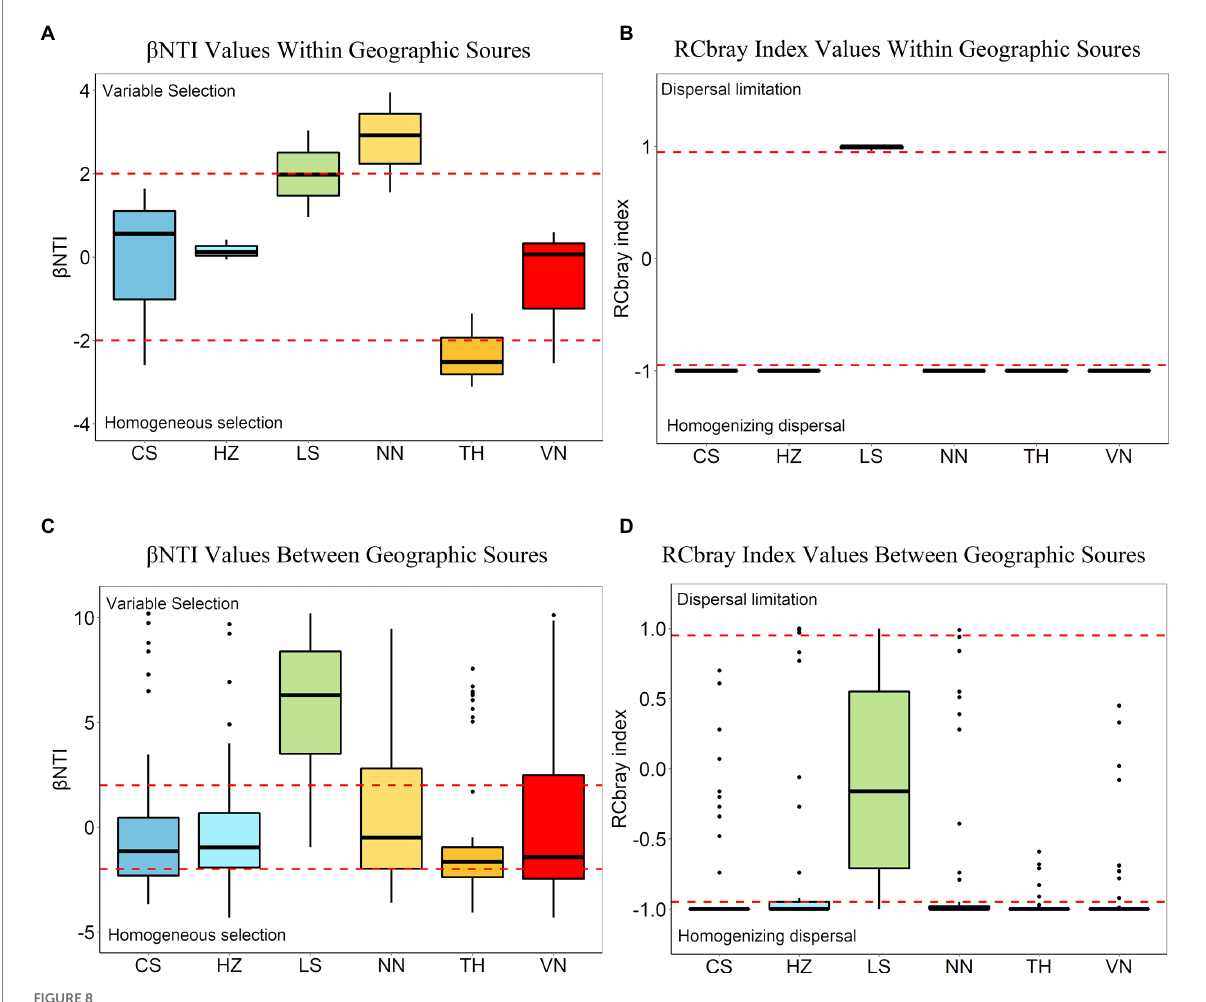
FIGURE 8 Boxplots showing the distribution of β NTI (A) and RCbray (B) values within geographic sources and the distribution of β NTI (C) and RCbray (D) values between geographic sources. Boxplots represent pairwise comparisons within geographic sources (A,B) and pairwise comparisons between geographic sources (C,D) . The dashed black line in the plots represents the null expectation. Dashed red lines in each plot represent significance thresholds for both the β NTI and RCbray metrics. Plotted RCbray values (B,D) do not include values from pairwise comparisons that have significant β NTI values. Boxplots display the distribution of the data, whereas the main colored box displays the interquartile range (25th to 75th percentile) of the data. Solid lines within the boxes represent the median of the data. Whiskers on the plot display the maximum and minimum expected values of the data distribution, and black-colored points represent outlier data points with respect to the plotted